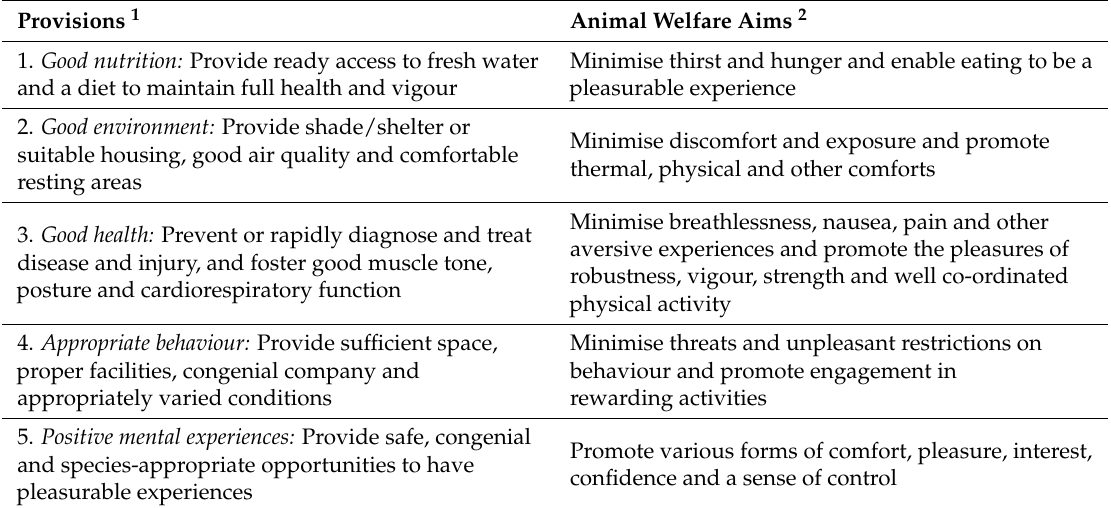
Table 2. The updated Five Provisions and aligned Animal Welfare